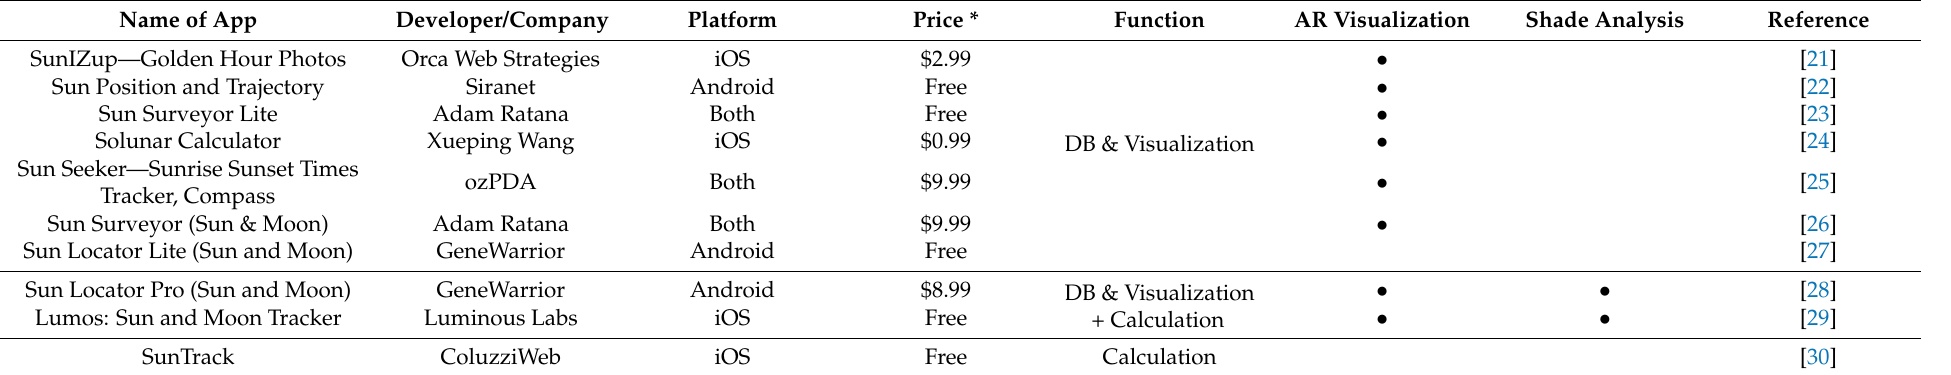
Table 3. Summary of smartphone applications that compute the sun’s